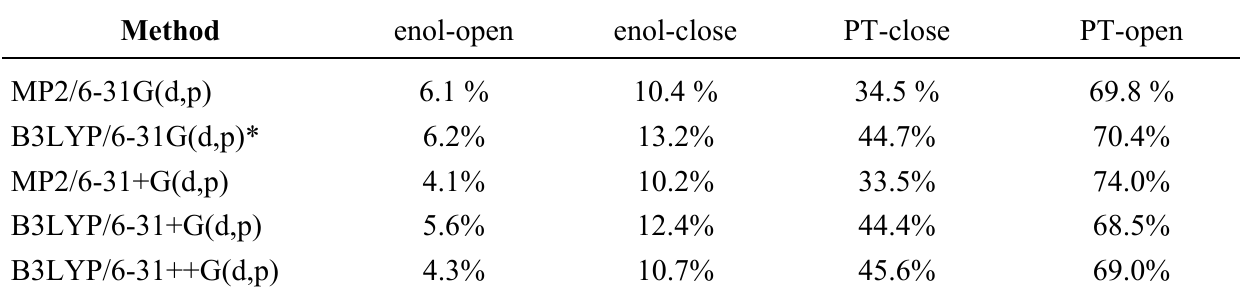
Table 1. Calculated content of keto structure in particular forms of Schift